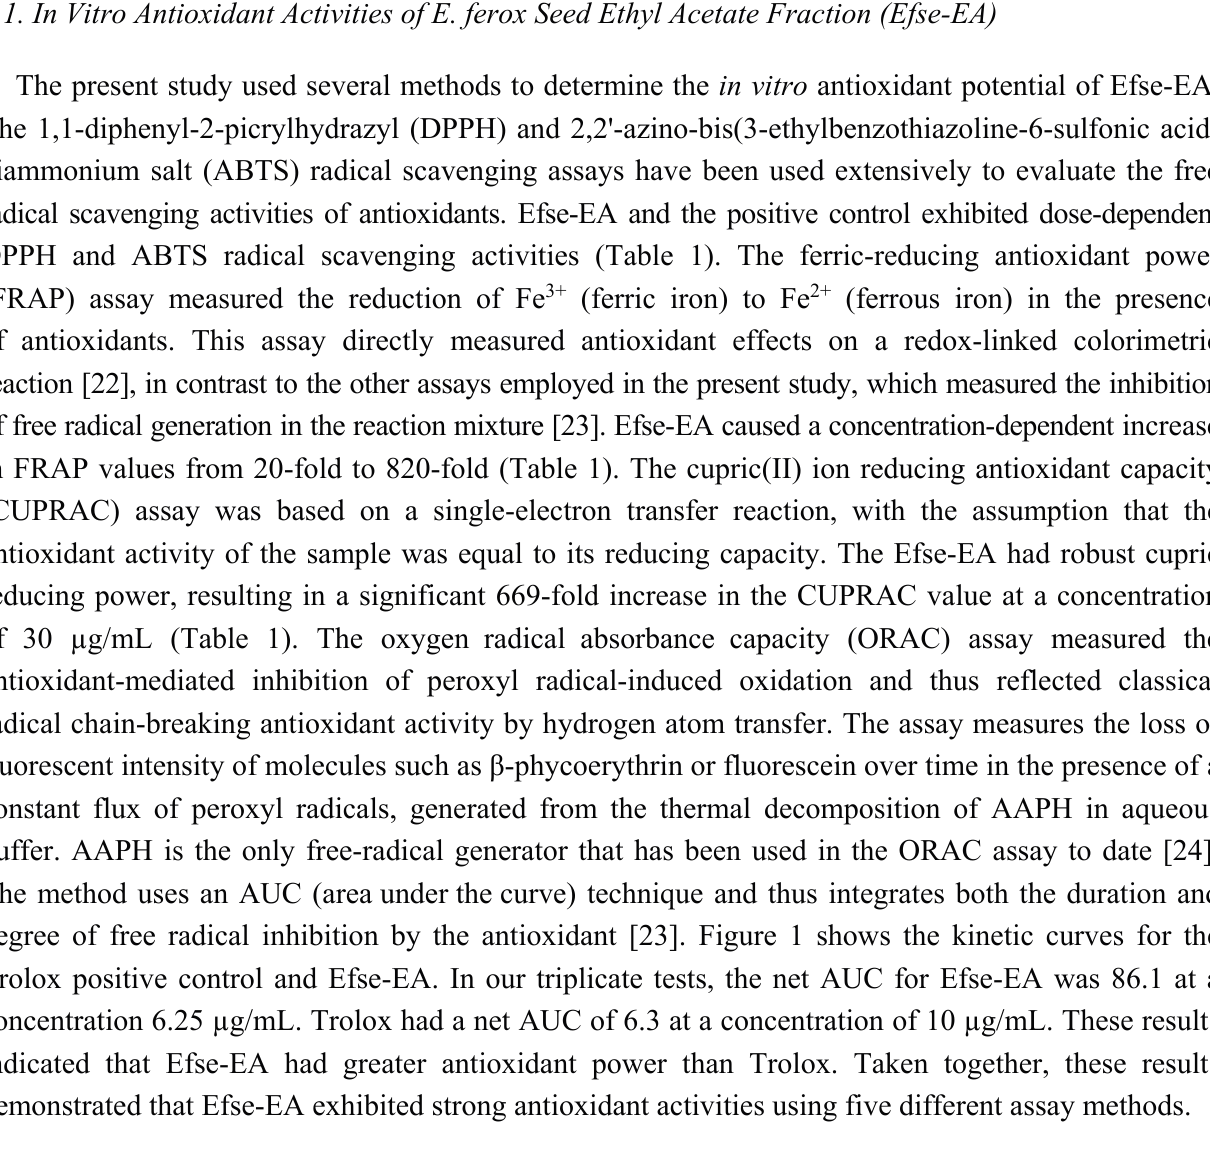
Table 1. Anti-oxidant activity of E. ferox seed ethyl acetate fraction (Efse-EA) in various in vitro assay